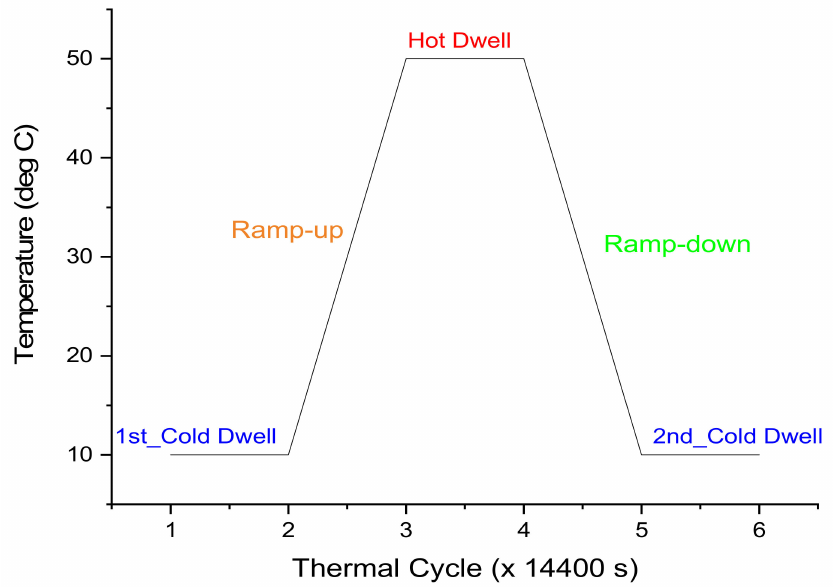
Figure 3. Typical daily thermal